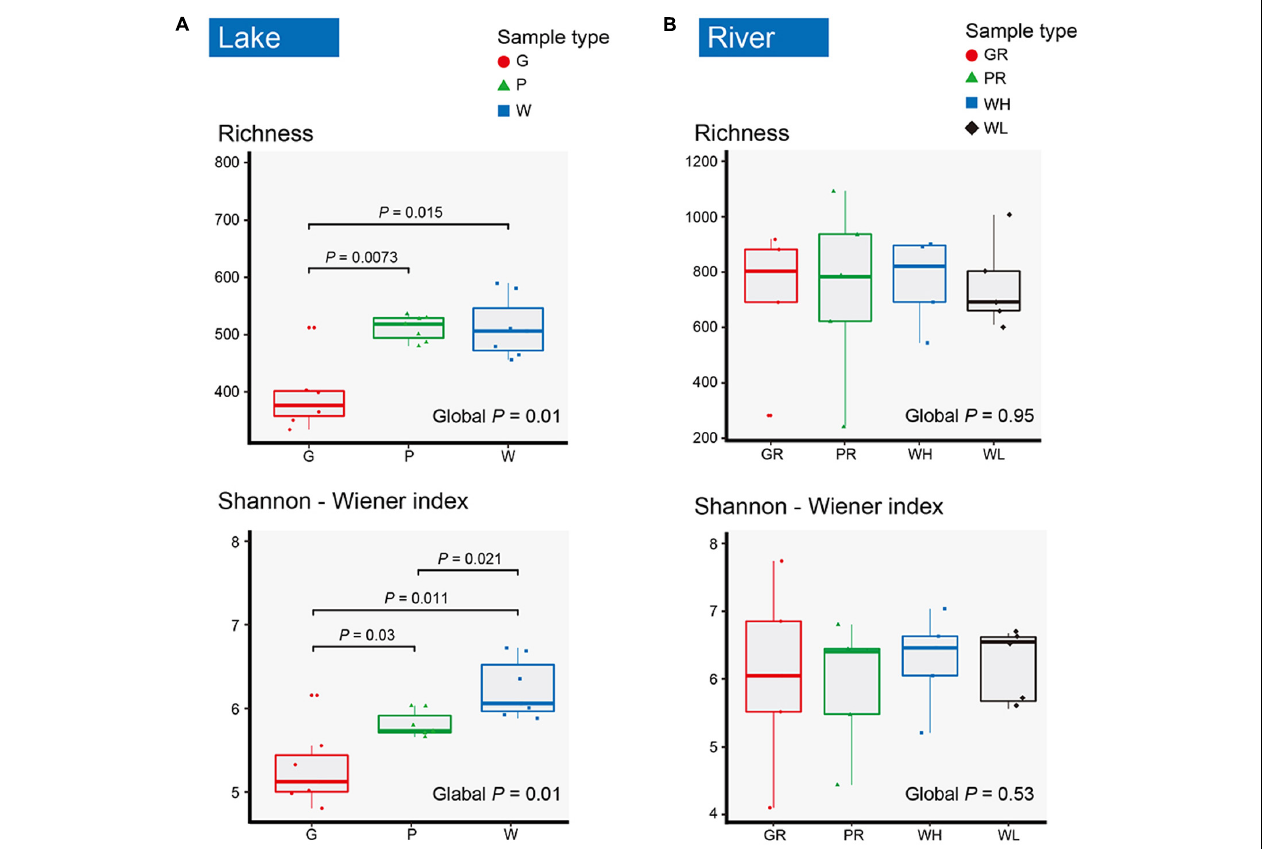
FIGURE 3 | The boxplots for richness and Shannon–Wiener index of microeukaryotes in lake (A) and river (B) . Samples are named as follows: G, glass slides in Ming Lake; P, PFUs in Ming Lake; W, water columns in Ming Lake; GR, glass slides in Pearl River; PR, PFUs in Pearl River; WH, water columns at high tide in Pearl River; WL, water columns at low tide in Pearl River. The global P -value represents the significance among sample types in lake and river. The significant P -value between two sample types is shown ( P < 0.05). Significance tests were based on Kruskal–Wallis test.